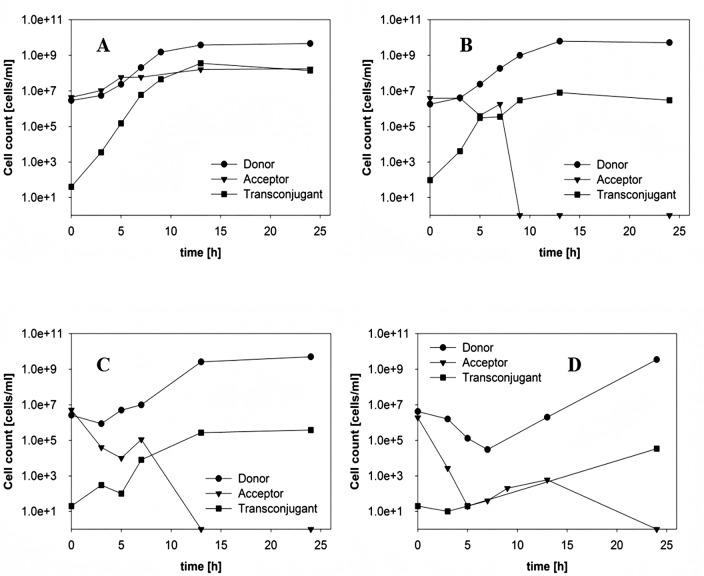
Transfer of pESBL-283 from ESBL242 (donor, ampR) to E. coli MG1655 (acceptor, chlorR) as a function of time during co-culture in a ratio of 1:1 with (A) 0 μg/ml, (B) 4 μg/ml, (C) 32 μg/ml and (D) 1024 μg/ml ampicillin in batch culture.